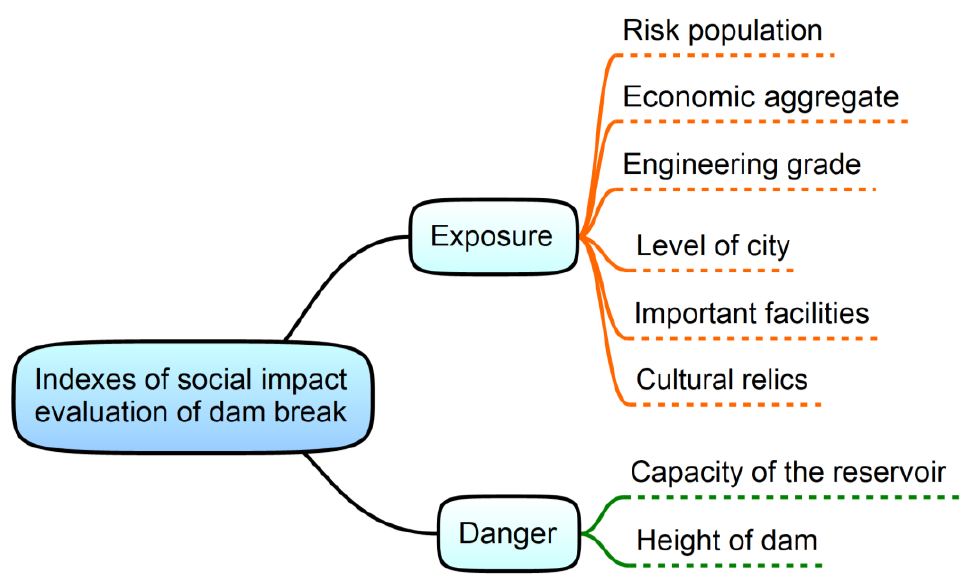
Figure 4. Index system of a social impact evaluation of a dam break.